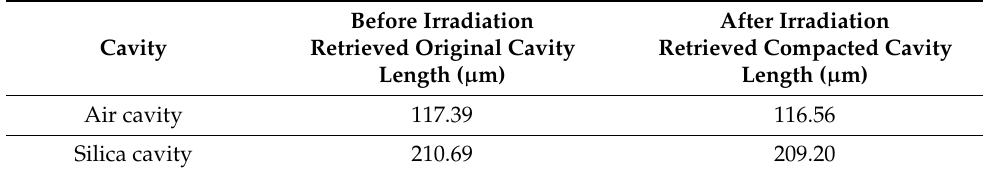
Figure 5. Reconstructed signals for ( a ) air cavity before irradiation, ( b ) air cavity after irradiation, ( c ) silica cavity before irradiation, ( d ) silica cavity after irradiation. Table 2. Reconstructed cavity lengths before and after irradiation to a fast fluence of 2.4 × 10 21 n/cm 2 at a temperature of 95 ◦